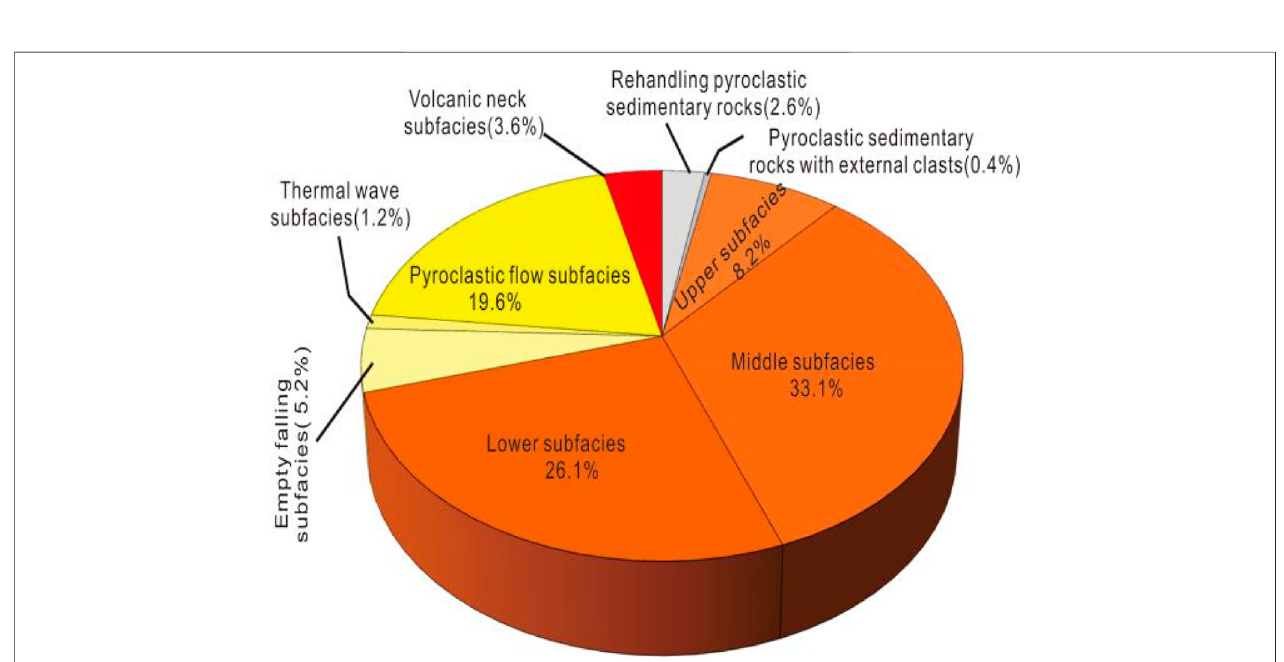
FIGURE 4 | Pie chart of volcanic lithofacies distribution in the Wangfu gas fi eld.